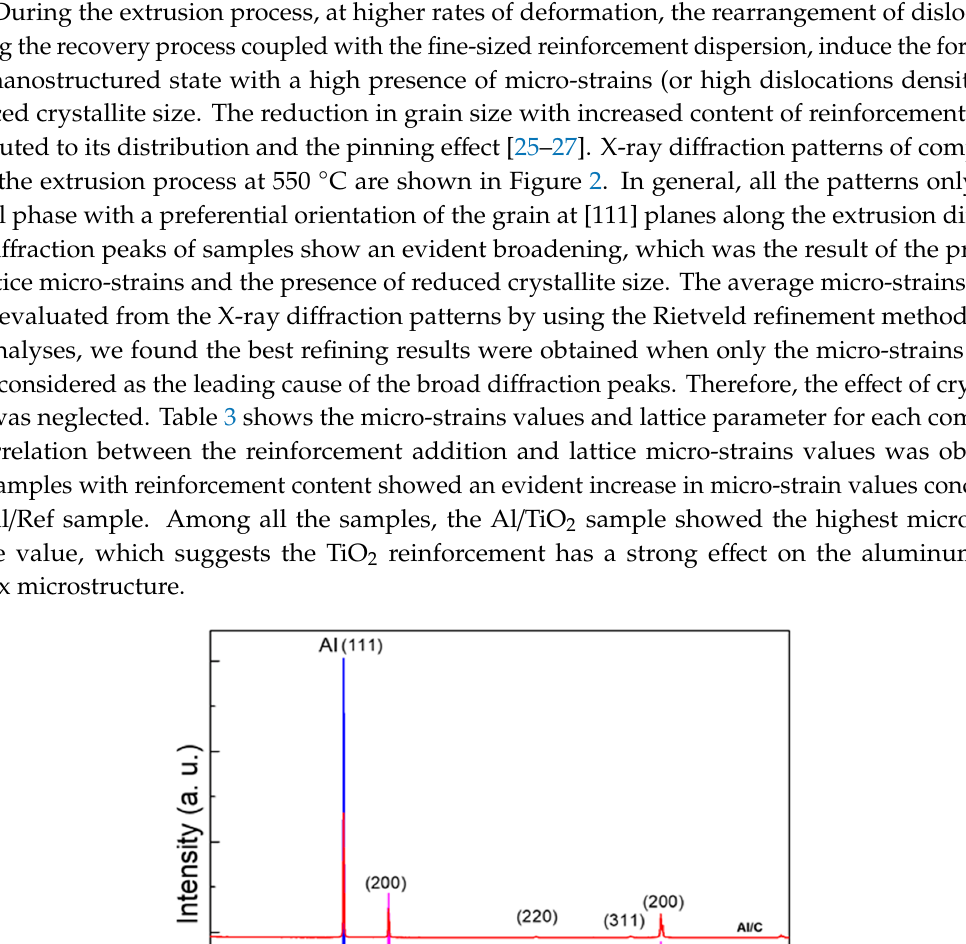
Figure 2. X-ray diffraction patterns of composites after the extrusion process at 550 °C.